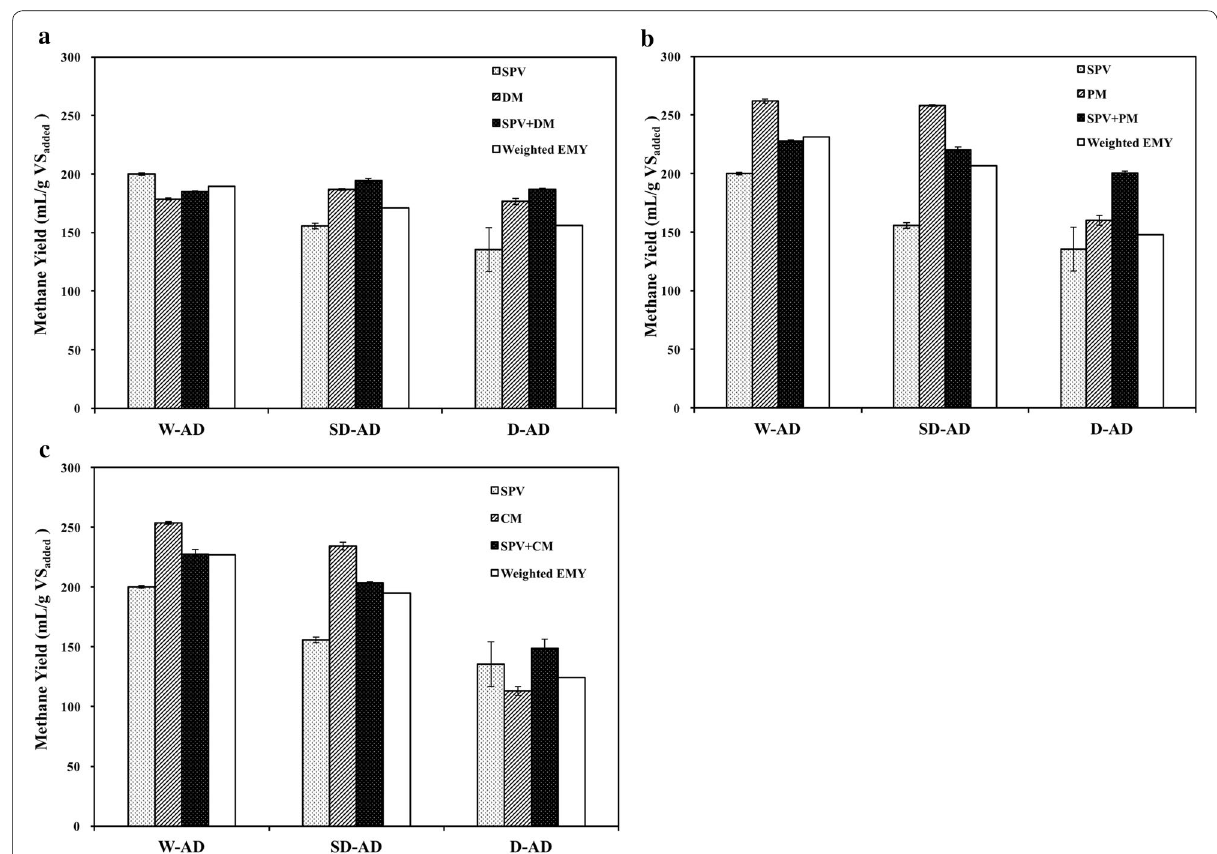
Fig. 4 Evaluation of synergistic effect of co-digestion with SPV and animal manure under various total solid conditions. a SPV SPV +